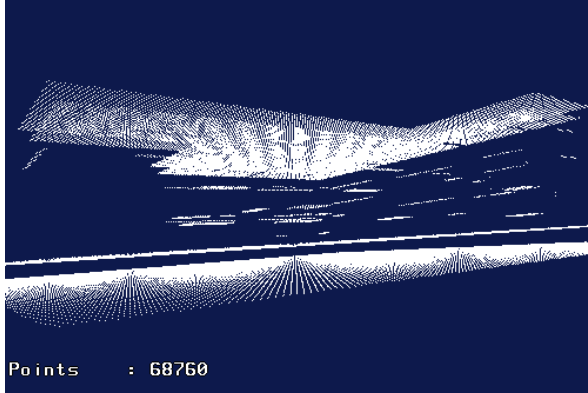
Fig. 12. Vector input for a building with interior rooms and furniture